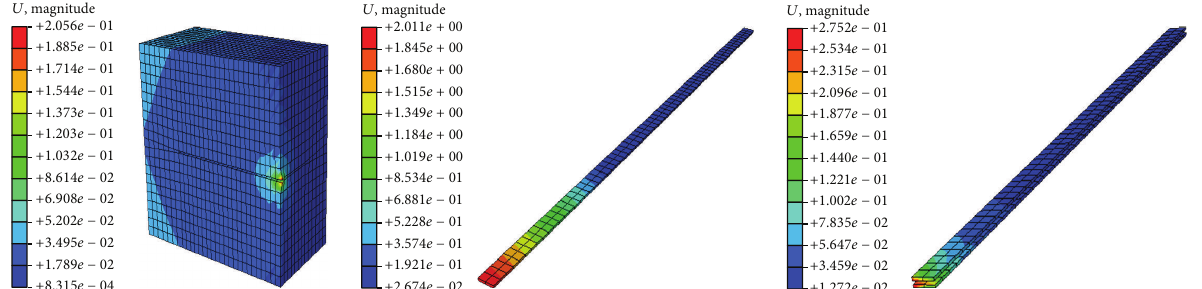
Figure 7: Displacement of concrete, FRP plate, and resin